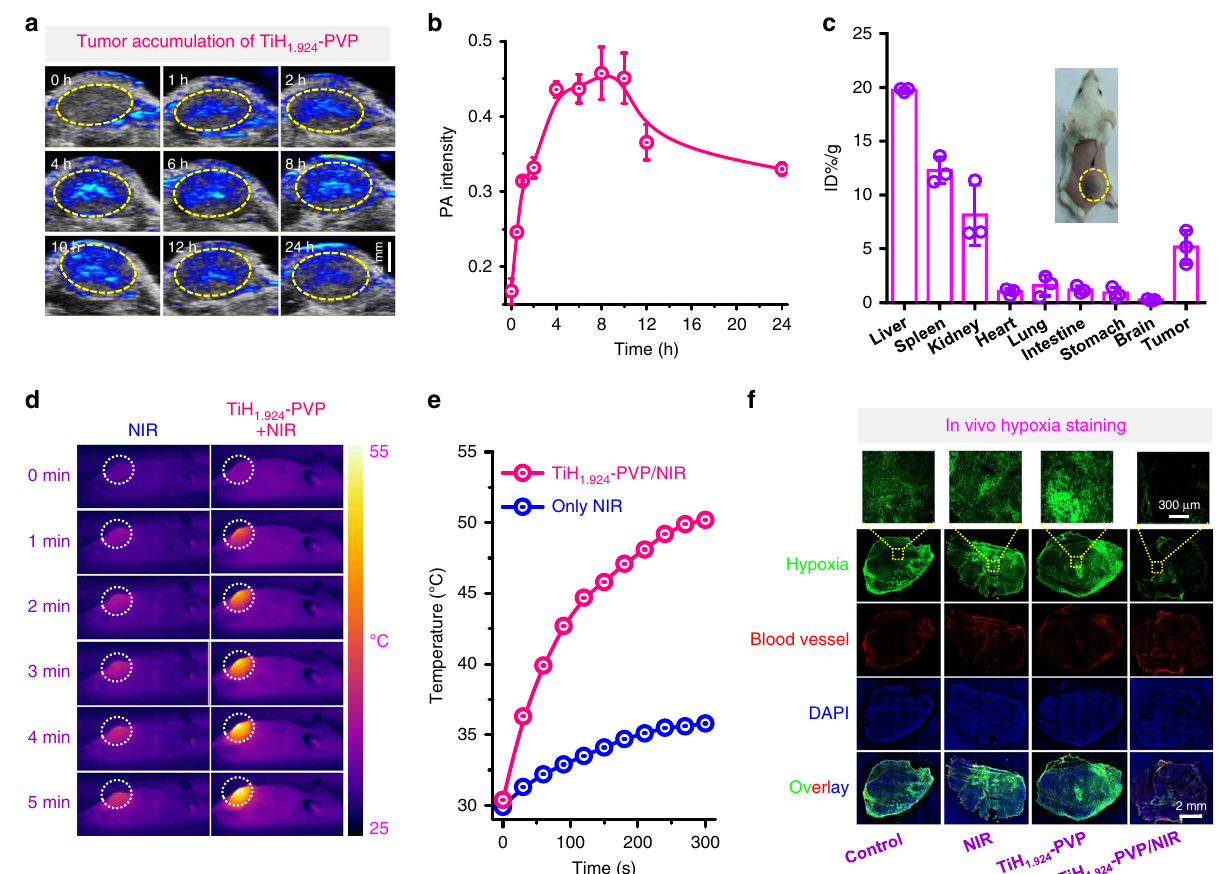
Fig. 5 In vivo tumor accumulation and mild PTT-defeated tumor hypoxia via TiH 1.924 -PVP. a In vivo PA imaging of 4T1 tumor-bearing mice after intravenously injected with TiH 1.924 -PVP. b Time-dependent tumor PA signals at 900nm based on PA imaging data in a ( n = 3 biologically independent mice). c Biodistribution of TiH 1.924 -PVP in mice ( n = 3 biologically independent mice). d , e IR thermal images ( d ) and temperature change curves ( e ) of 4T1 tumors under the 1064-nm laser irradiation, for untreated mice and TiH 1.924 -PVP injected mice (irradiated at 8 h p.i.). f Representative immuno fl uorescence images of tumor slices after hypoxia staining. The nuclei, blood vessels, and hypoxia areas were stained by DAPI (blue), anti-CD31 antibody (red), and antipimonidazole antibody (green), respectively. TiH 1.924 -PVP: 20 mg kg − 1 ; NIR laser: 1064 nm, 0.8 W cm − 2 , 20 min. A representative image of three biological replicates from each group is shown in f . Data are presented as mean values ±